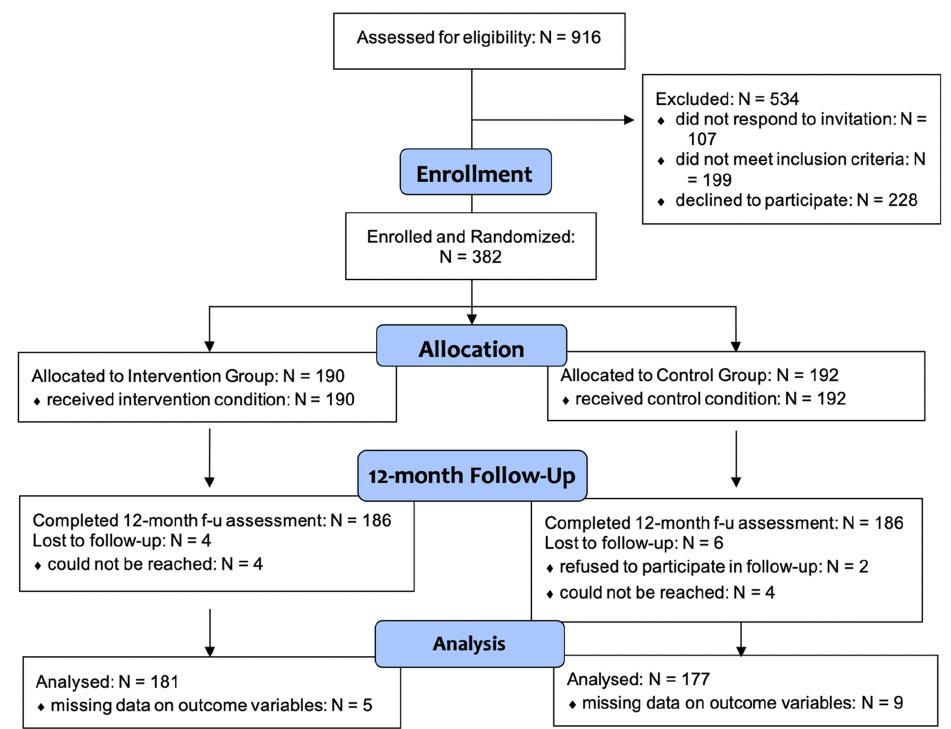
Figure 1. Consolidated Standards of Reporting Trials (CONSORT) Flow Diagram.